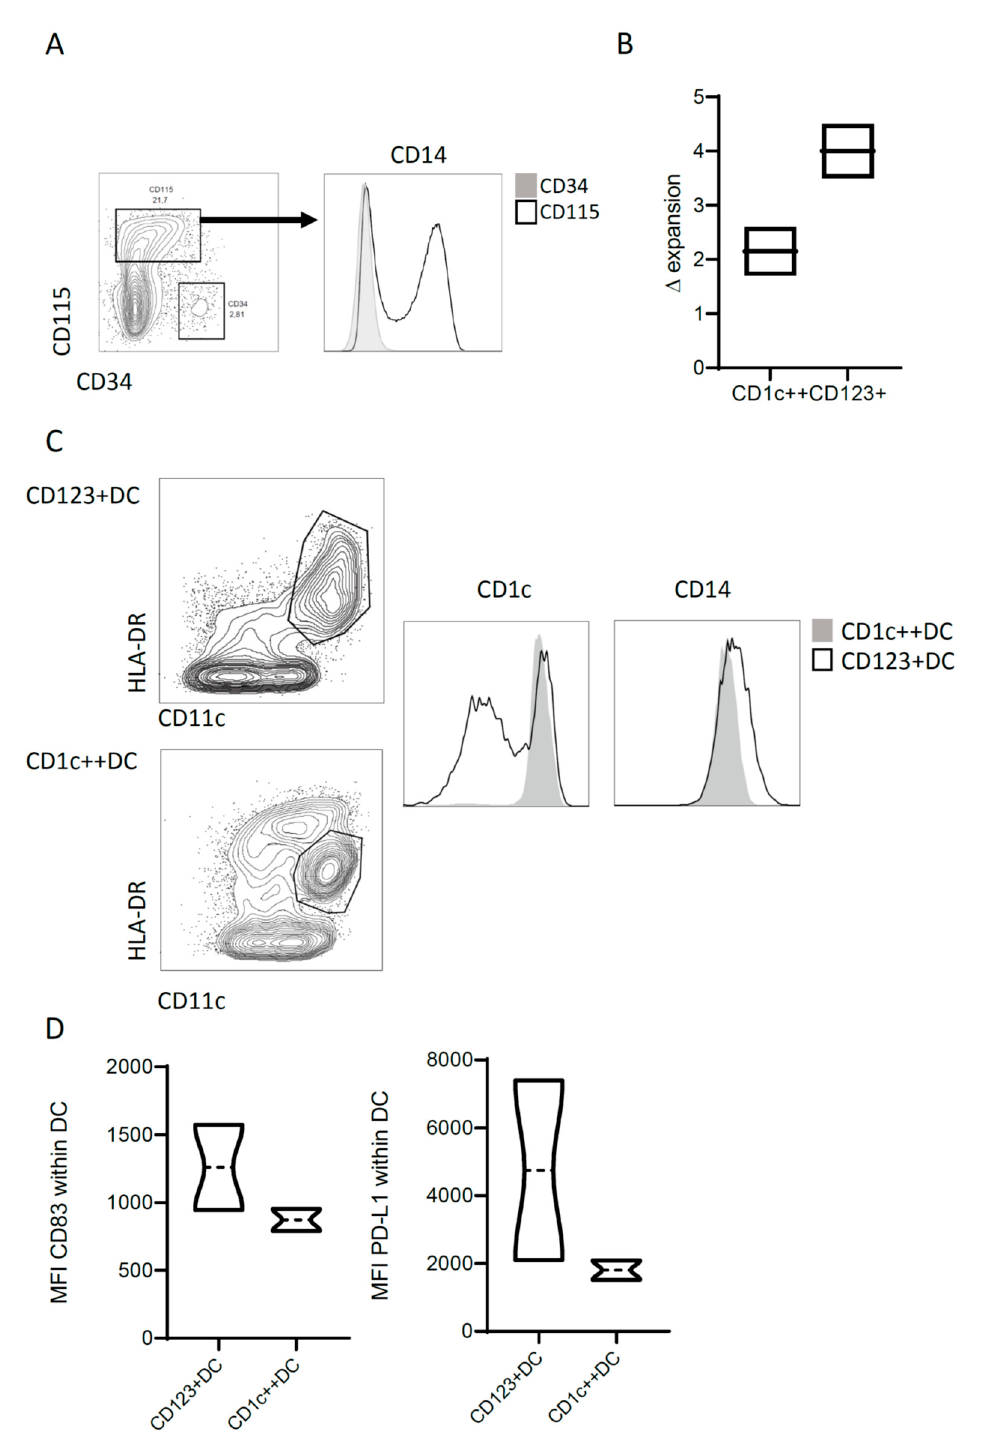
Figure 5. GMP translation of pre-clinical subsets. Two-week expansion of CD34+ followed by one week of differentiation to DCs. After expansion, either CD115+CD14 − or CD115+CD14+ were isolated and differentiated in closed culture bags. ( A ) Phenotype of precursors at day 14. ( B ) Expansion factor calculated per week by dividing the total cells after 1 week by the starting amount of that week. ( C ) Phenotype after differentiation using flow cytometry. ( D ) Phenotype after maturation using flow cytometry. These experiments were performed with two